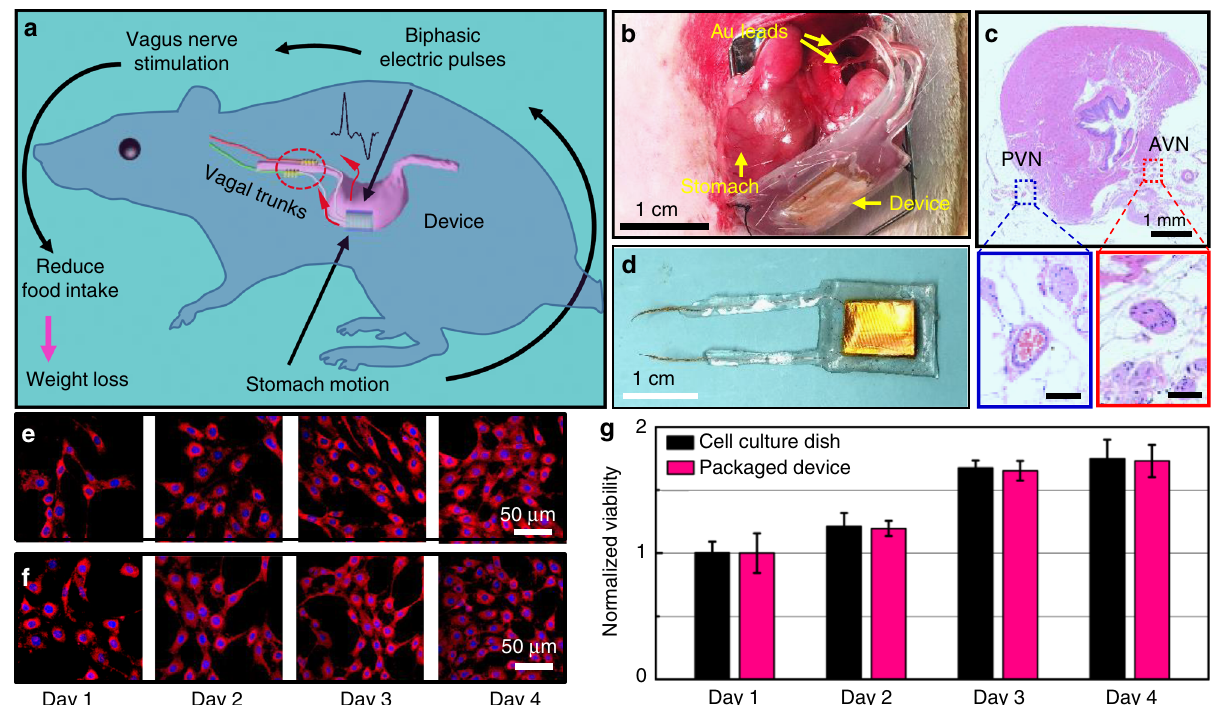
Fig. 1 The correlated vagus nerve stimulation (VNS) system and its biocompatibility. a Operation principle of the correlated VNS system schematically showing the pathway for biphasic electric signal generation and VNS. b An implanted VNS device with Au leads being connected to anterior and posterior vagal trunks. c Hematoxylin – eosin (H&E) staining of the implanted tissues (transverse section). Areas within the blue and red boxes are enlarged view of the anterior (red) and posterior (blue) vagus nerves (scale bar = 100 μ m). d A packaged VNS device. e , f Fluorescence images of stained 3T3 cells that were cultured on a regular cell culture dish ( e ) and on the surface of a packaged device ( f ). g Comparison of normalized cell viability for 4 days showing excellent biocompatibility of the packaged device ( n = 3 for each group). All data in g are presented as mean ±